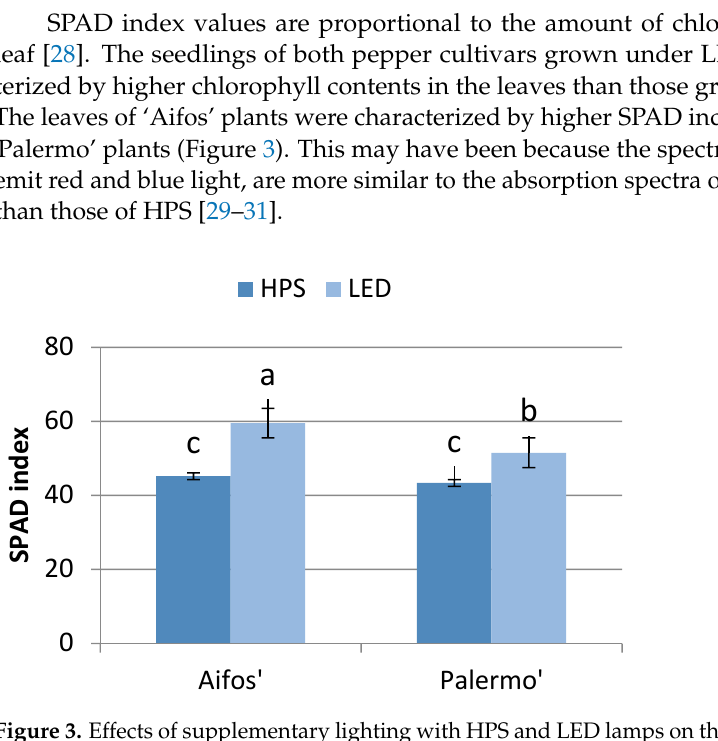
Figure 3. Effects of supplementary lighting with HPS and LED lamps on the chlorophyll index values in pepper leaves, depending on the cultivar (averages of four measurement dates). The mean values marked with the same letters do not differ significantly according to the Tukey HSD test at α = 0.05. The bars represent means ±SE. Table 1. Effects of supplementary lighting with sodium and LED lamps on the photosynthetic activity of pepper seedling leaves according to the cultivar (averages of four measurement dates).